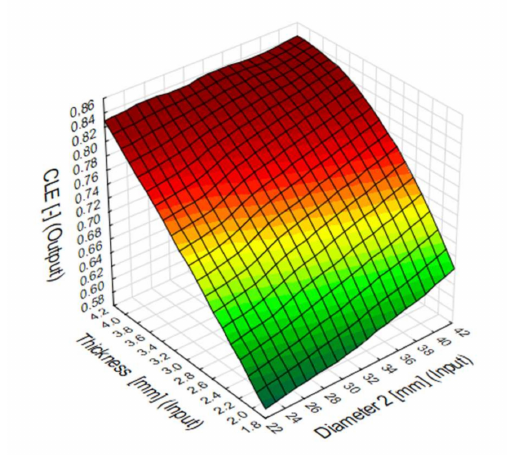
Figure 20. Crush load e ffi ciency (CLE) predicted by MLP 2-4-1 artificial neural